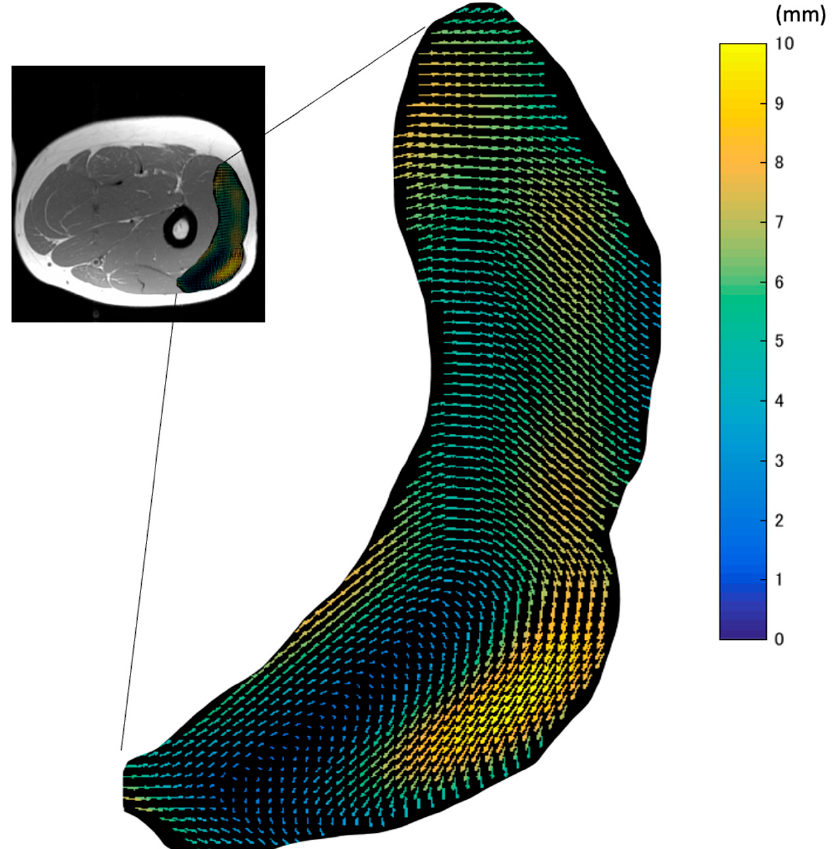
Figure 4. A map of the vectors of the in-plane maximal displacement of VL from the relax phase. The length and color of arrows in VL show the magnitudes of the vectors.